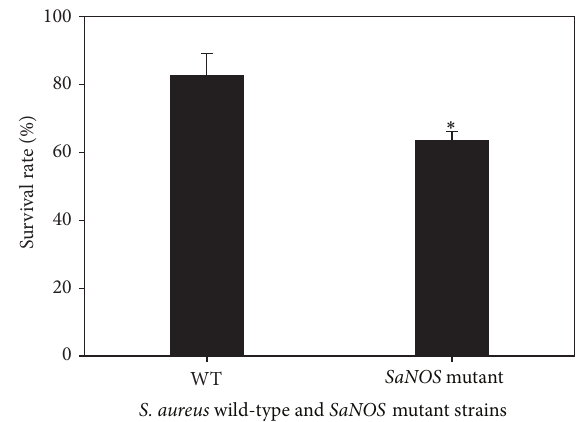
Figure 3: S. aureus survival in neutrophil cells. Neutrophil cells were infected (MOI 1:2.5) with wild-type S. aureus SH1000 and its isogenic SaNOS mutant for 1h at 37 ∘ C and then plated on TSA plate. ∗ Significant at 𝑃 < 0.05